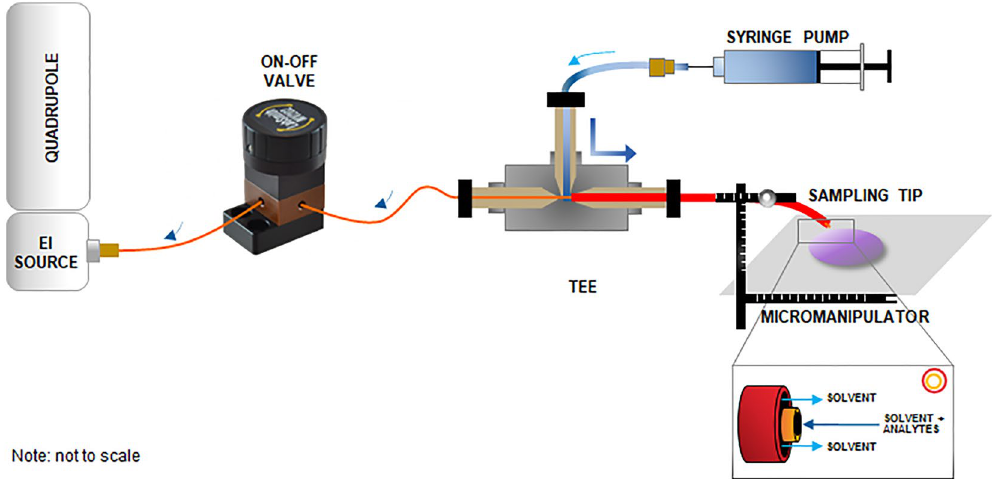
Figure 1. Configuration of the E-LEI-MS